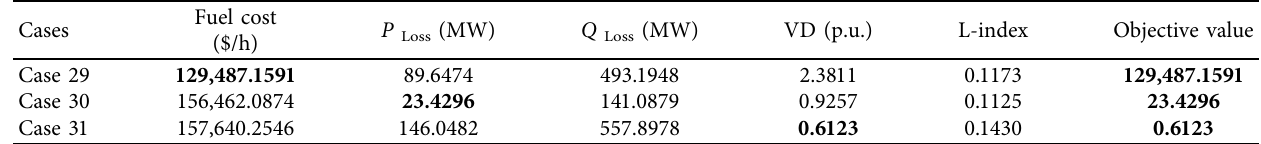
Te best objective values are highlighted in the bold